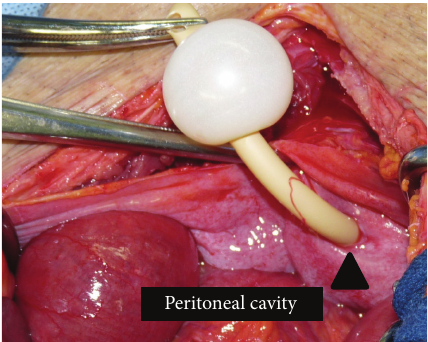
Figure 4: A perforated tear of about 6 mm was discovered at the dome of the urinary bladder ( 󳵳 ) where the Foley catheter was penetrating. The Foley catheter balloon was floating freely in the peritoneal